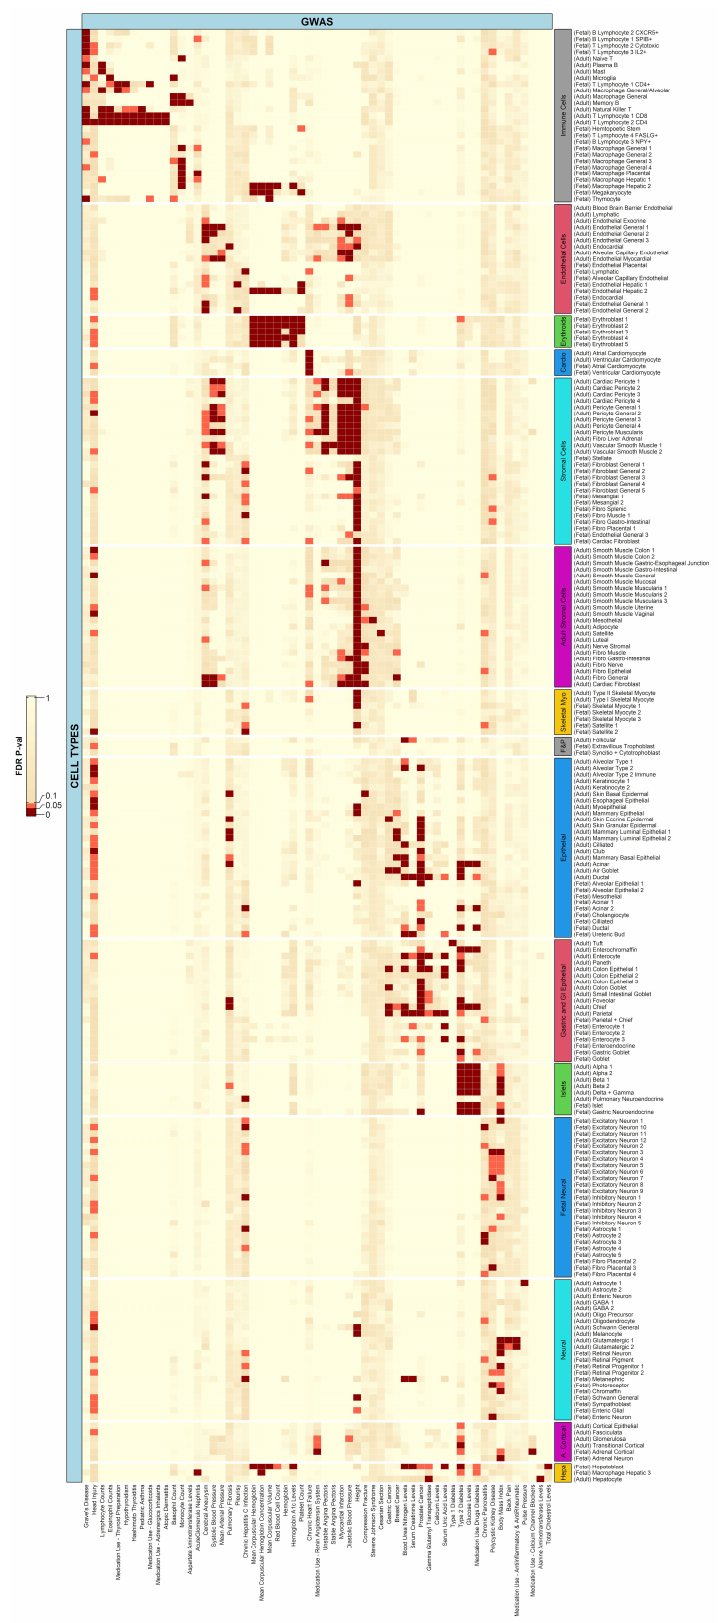
Figure 2. Heatmap depicting associations of scATAC-seq data for 222 cell types with 59 phenotypes. Of 201 phenotypes, 59 had a significant association (FDR adjusted p -value ≤ 0.05) with at least one cell